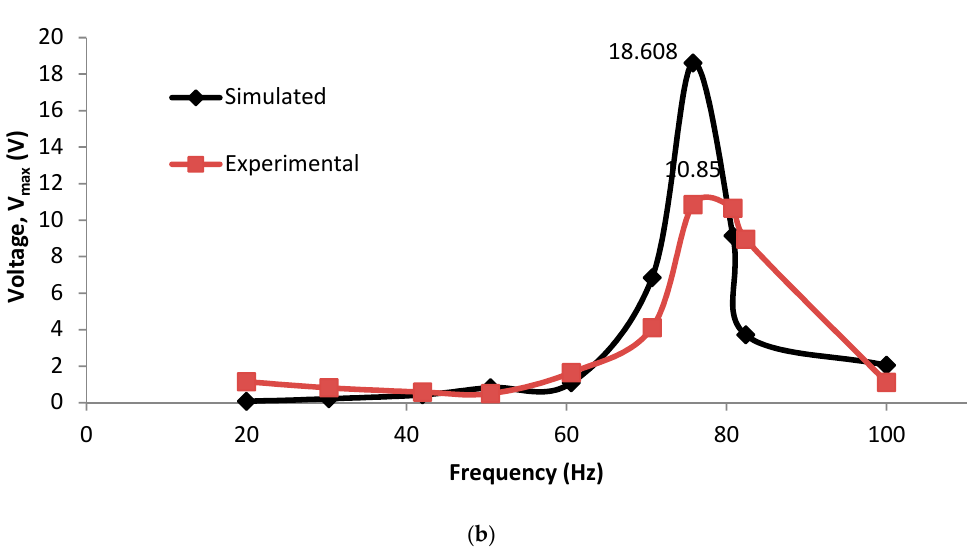
Figure 21. Voltage against ( a ) wind speed ( b ) frequency.